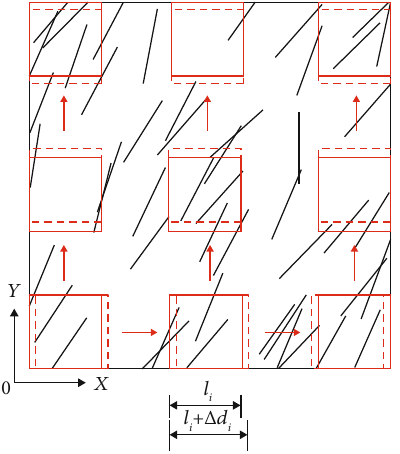
Figure 3: Progressive coverage statistical